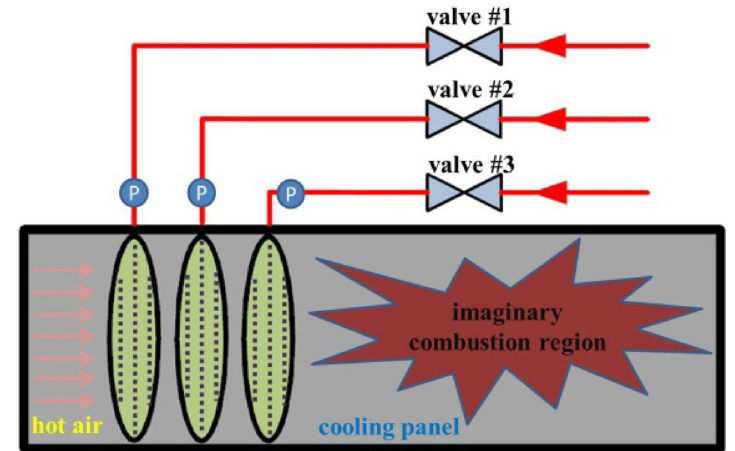
Fig. 6 The regulating scheme of the area of fuel injecting